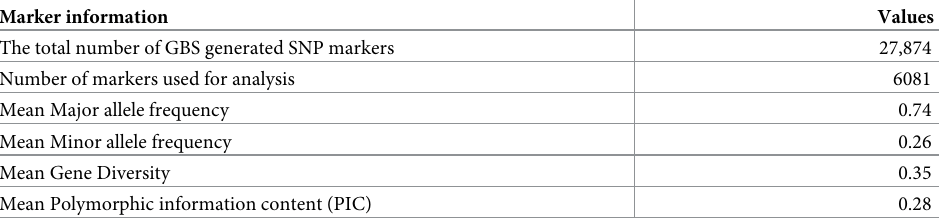
Table 1. Summary of diversity analysis of 30 Striga resistant inbred lines and three testers with varying levels of resistance to Striga .